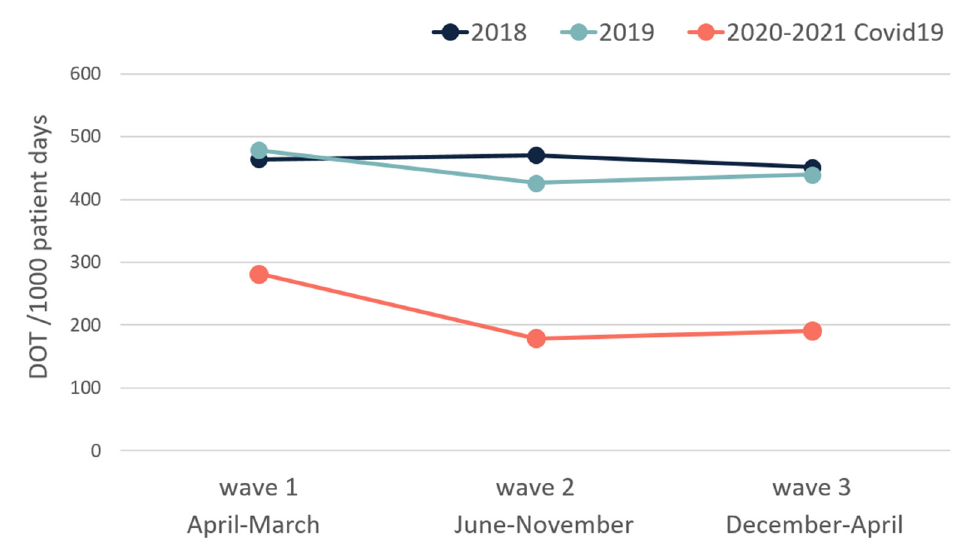
Figure 1. Cumulative DOT per 1000 patient days in each wave and in the same medical departments at the same calendar months of 2018 and 2019.